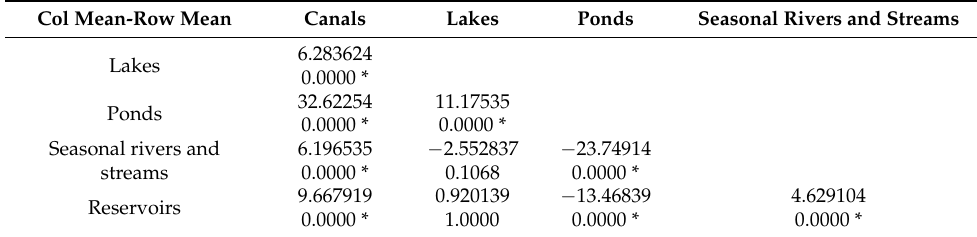
Table A6. 2015 Dunn’s post hoc tests, with p -values adjusted with the Bonferroni method. Col Mean-Row